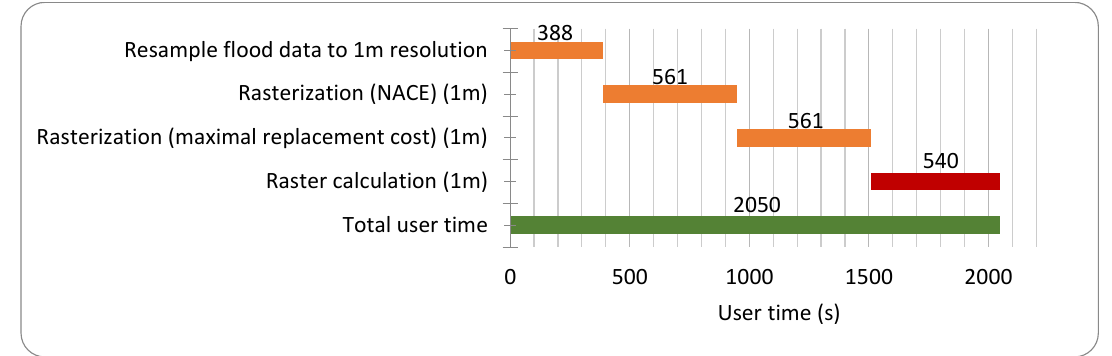
Figure 21. User time to calculate the economic impact for a road network in Ghent resulting from a fluvial flood event (return period 1000 years) with a raster approach (5 m resolution).